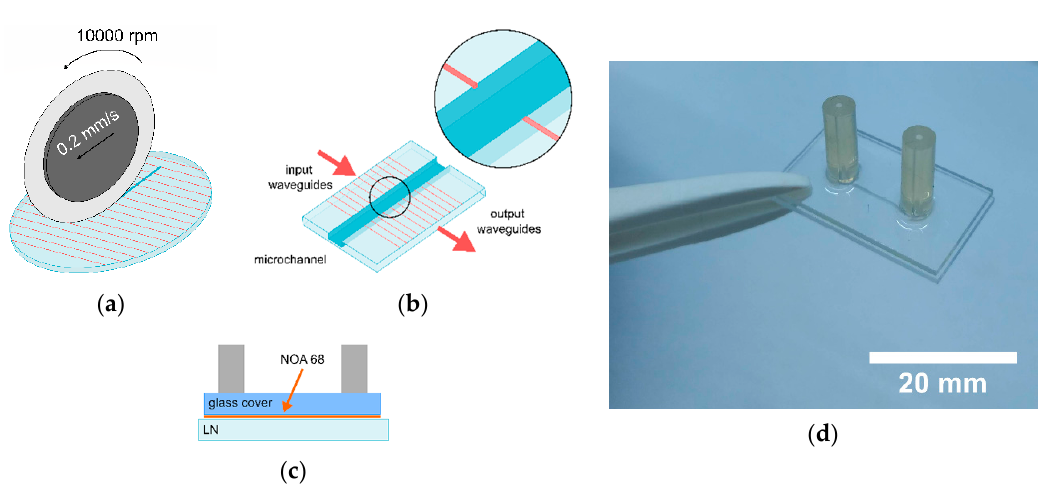
Figure 2. Schematic representation of the final steps realized to obtain the complete device. ( a ) The cutting technique allows one to engrave the microchannel and cut the samples from Ti:LN wafer. ( b ) The waveguides are divided by the microchannel in two branches, named input and output waveguides. The inset evidences the coupling of the waveguides and the channel. ( c ) The sample obtained from the Ti:LN is sealed with a glass cover and UV curable glue. ( d ) Picture of the final device.